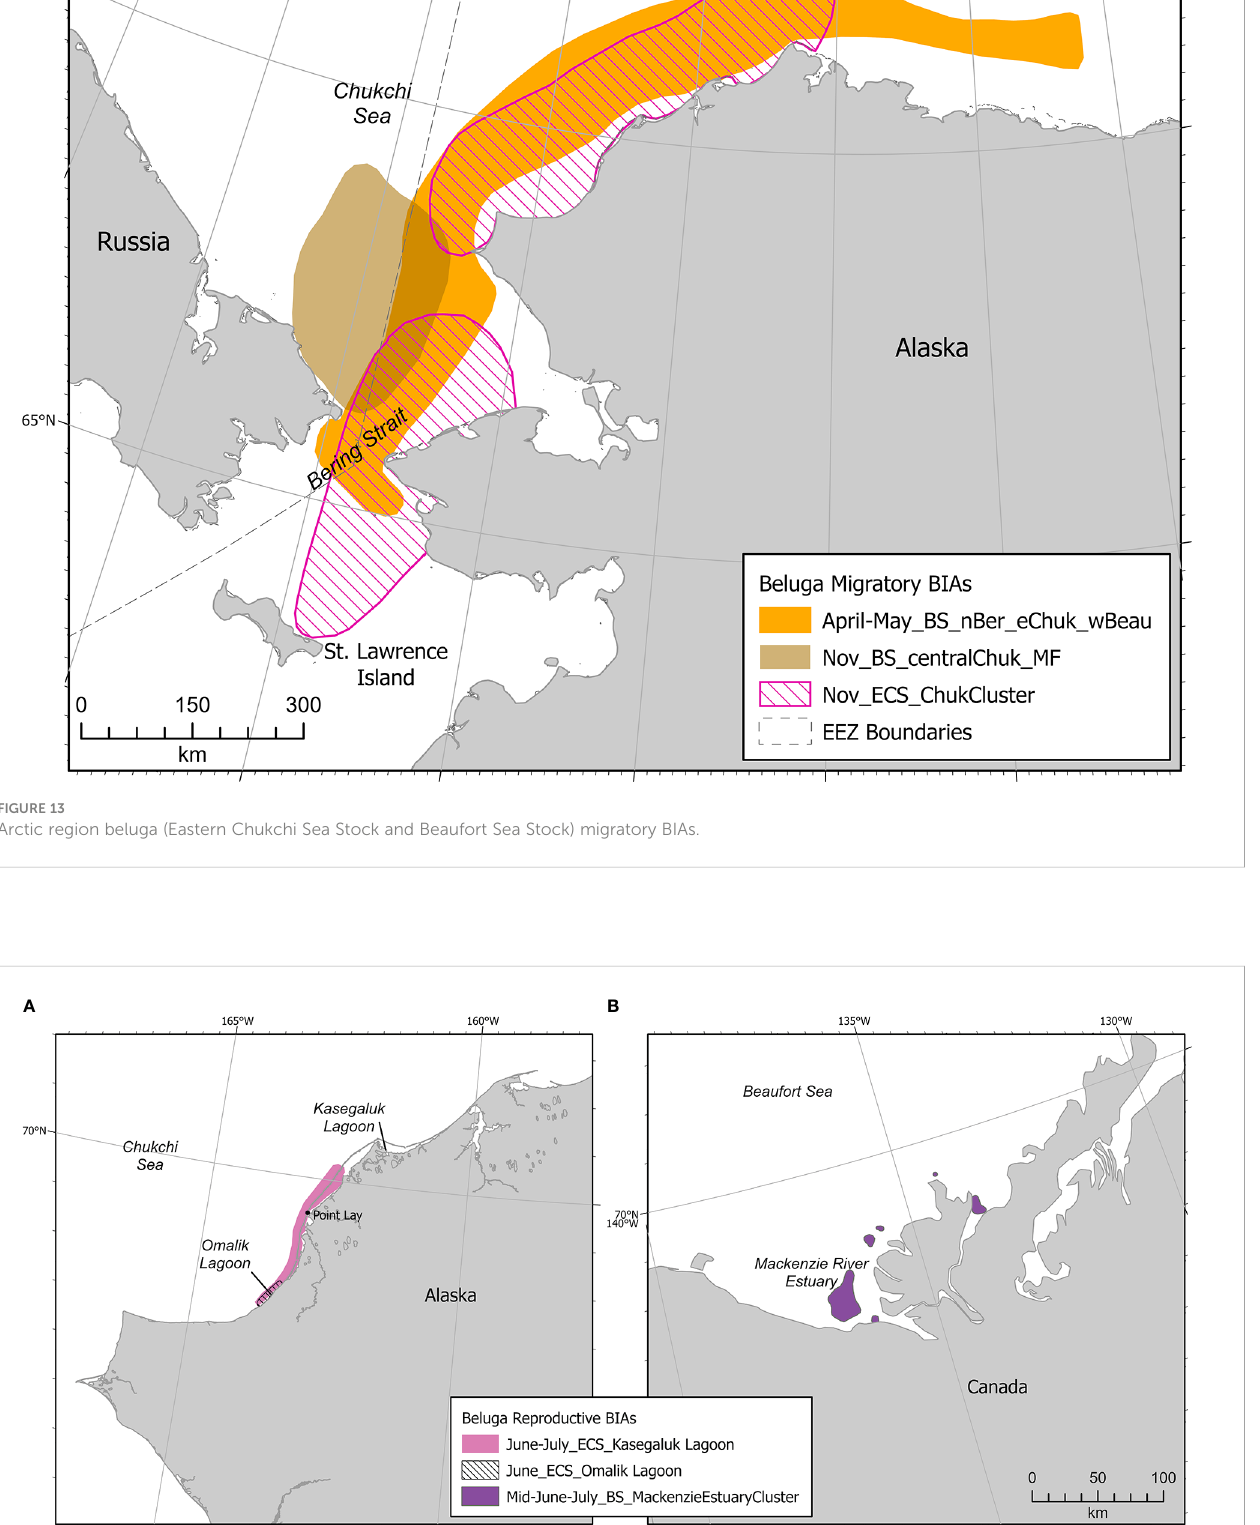
FIGURE 14 Arctic region beluga reproductive BIAs. (A) Eastern Chukchi Sea Stock; (B) Beaufort Sea Stock.